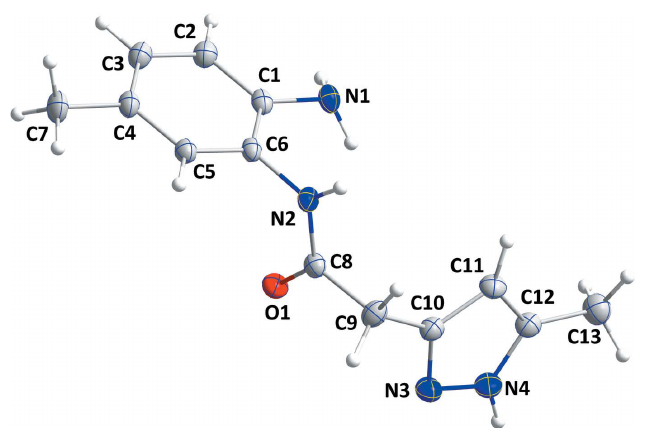
Figure 1 Molecular structure of the title compound with the labelling scheme. The ellipsoids are drawn at the 50% probability level.